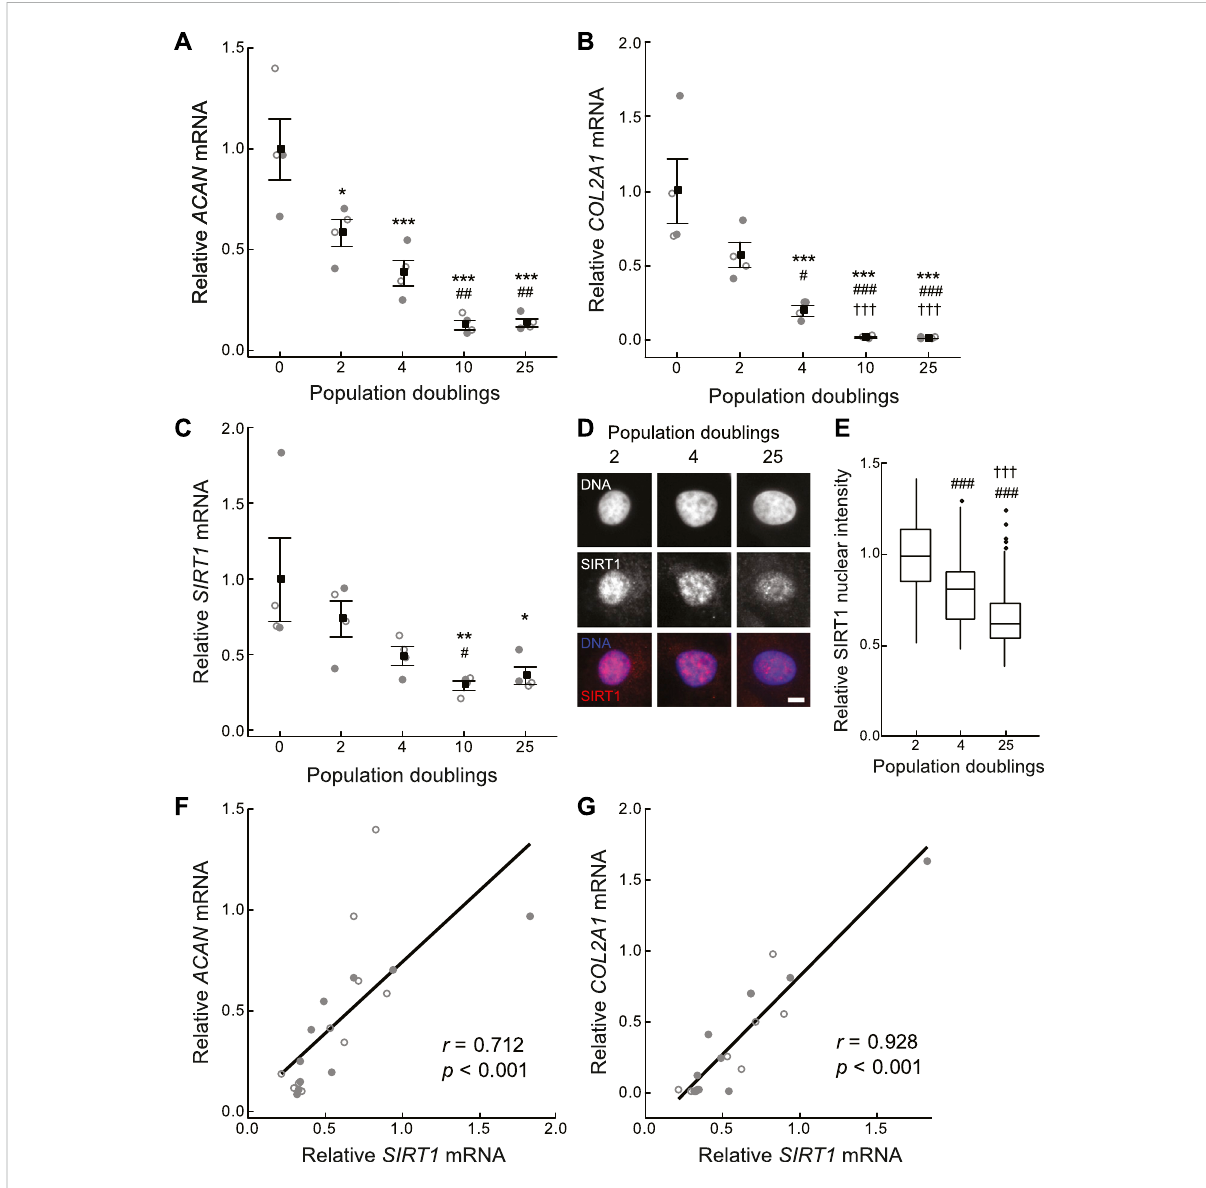
FIGURE 2 Cartilage matrix and sirtuin 1 gene expression declines during in vitro monolayer expansion of primary chondrocytes. (A – C) Gene expression of (A) aggrecan ( ACAN ), (B) collagen type II α -1 chain ( COL2A1 ) and (C) sirtuin 1 ( SIRT1 ) is normalised to β -2-microglobulin ( B2M ) and β -actin ( ACTB ) endogenous control genes and presented relative to 0 population doublings (PDs). Mean ± s.e.m., n = 4 from two experiments withindividualdata pointsrepresentedbyopenandclosedcirclesrespectively, General linearmodelwith Tukeypairwisecomparisons:* p < 0.05, ** p < 0.01 and *** p < 0.001 vs. 0 PDs, # p < 0.05, ## p < 0.01 and ### p < 0.001 vs. 2 PDs, ††† p < 0.001 vs. 4 PDs. (D) Representative nuclear SIRT1 immuno fl uorescent staining. Scale bar 5 µm. (E) Nuclear SIRT1 protein levels relative to 2 PDs. Boxes represent median and interquartile range, with whiskers extending to 1.5 × interquartile range or the max/min data points, n 2PD = 140, n 4PD = 113, n 25PD = 354 cells, General linear model with Tukey pairwise comparisons: ### p < 0.001 vs. 2 PDs, ††† p < 0.001 vs. 4 PDs. (F,G) Scatter plots of (F) ACAN , and (G) COL2A1